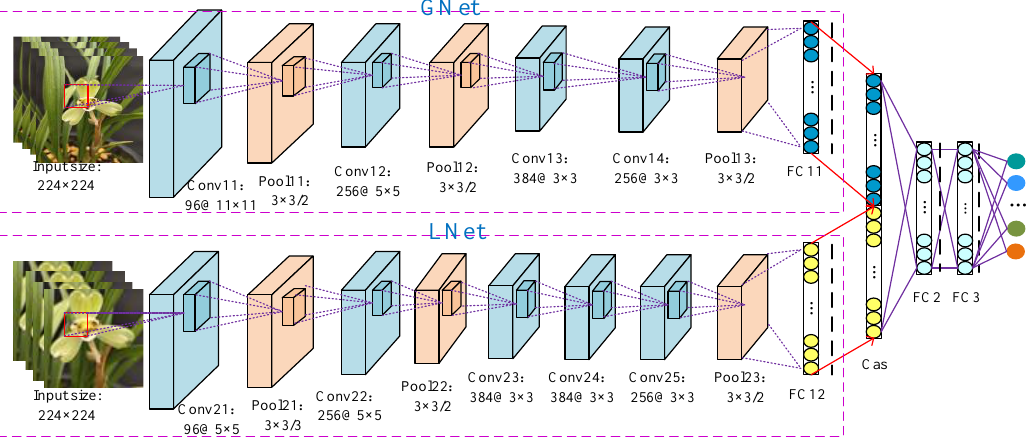
Figure 4. GL-CNN network structure diagram.